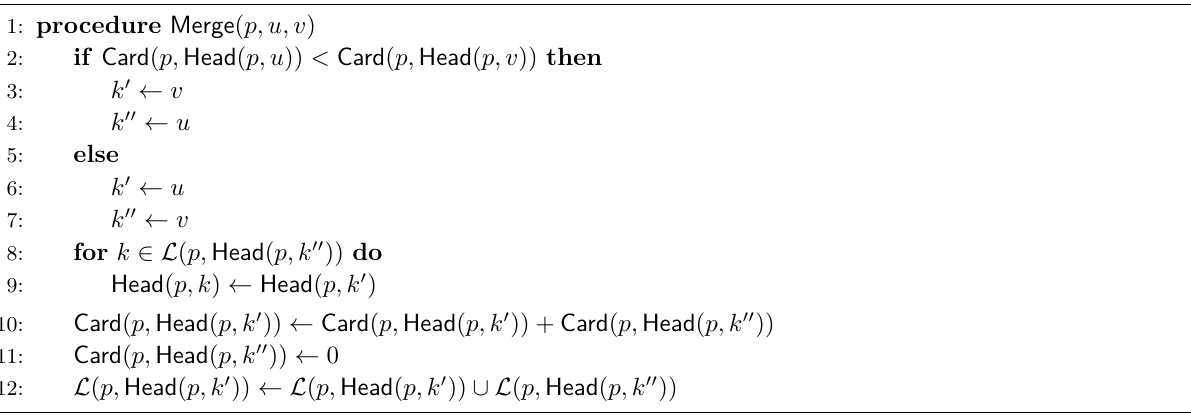
Algorithm 12 The procedure that merges two lists in the Union-Find data-structure of a local subgraph G ( p